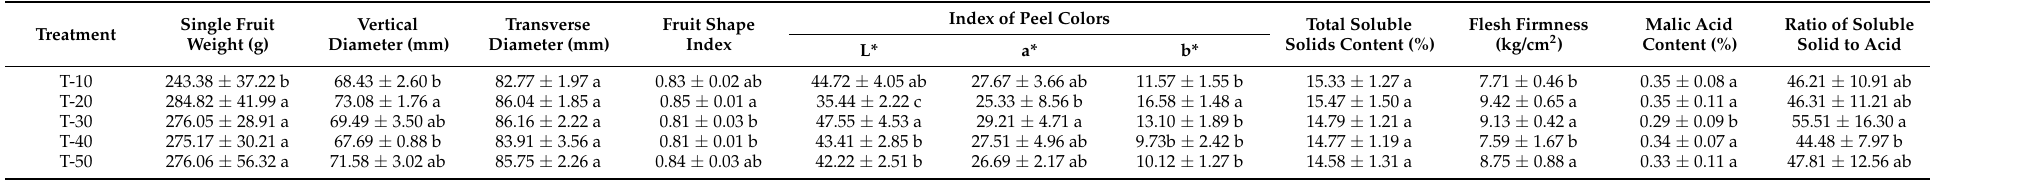
Table 7. Effects of interstock length on fruit quality